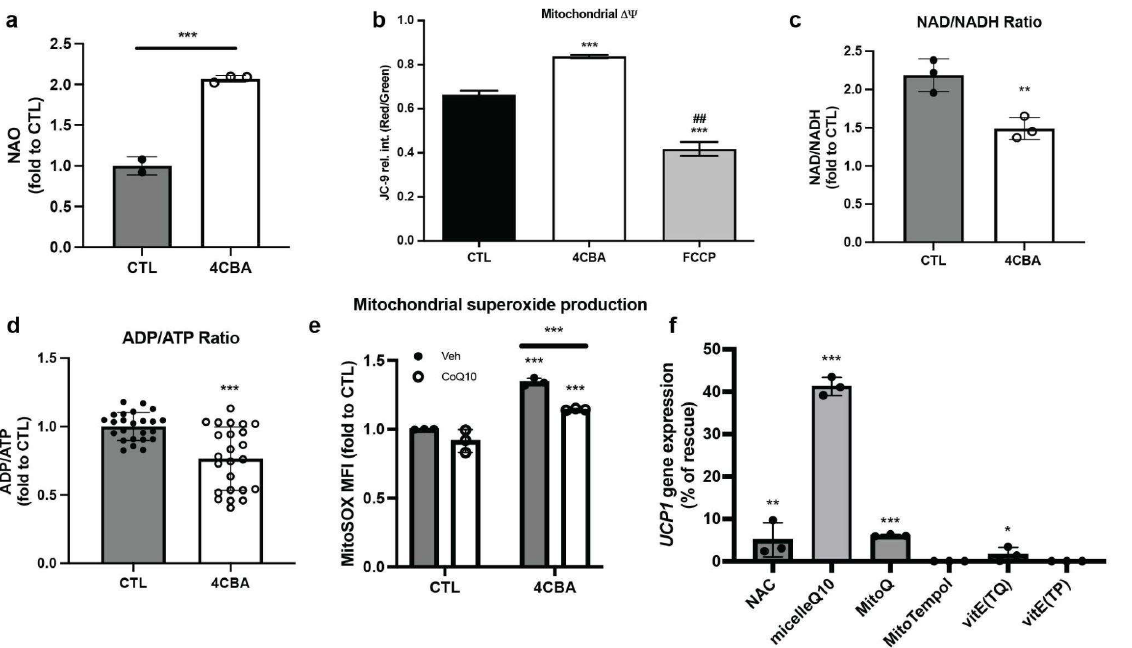
Figure 3. BAT CoQ deficiency alters mitochondrial bioenergetics and redox function. ( a ) Mitochondrial mass, measured by flow cytometry using nonyl acridine orange (NAO), a fluorescent dye, was increased after treatment with 4CBA in comparison to the vehicle (CTL), n = 3. ( b ) Mitochondrial membrane potential ∆Ψ was detected using fluorescent dye JC-9 by confocal microscope and was found to be increased in 4CBA treated cells. Green and red fluorescence intensity was measured from 4 randomly selected images using Imaris software and presented in a Red/Green ratio. ## p < 0.01 compared to 4CBA treatment. ( c ) NAD+ to NADH and ( d ) ADP to ATP ratios were measured using an ELISA kit and were both decreased after treatment with 4CBA. ( e ) Mitochondrial superoxide in brown adipocytes was increased after 4CBA treatment. CoQ 10 supplementation partially rescued superoxide production in 4CBA-treated cells. Mitochondrial superoxide production was detected using MitoSOX by flow cytometry, n = 3. 4CBA treatment ( f ) Murine brown adipocytes were treated with 4CBA in the presence of various antioxidants, n = 3. MicelleQ10 rescued UCP1 suppression by ~45%. Data represent mean ± SEM. Significance presented at * p < 0.05, ** p < 0.01, and *** p < 0.001 compared to controls or otherwise